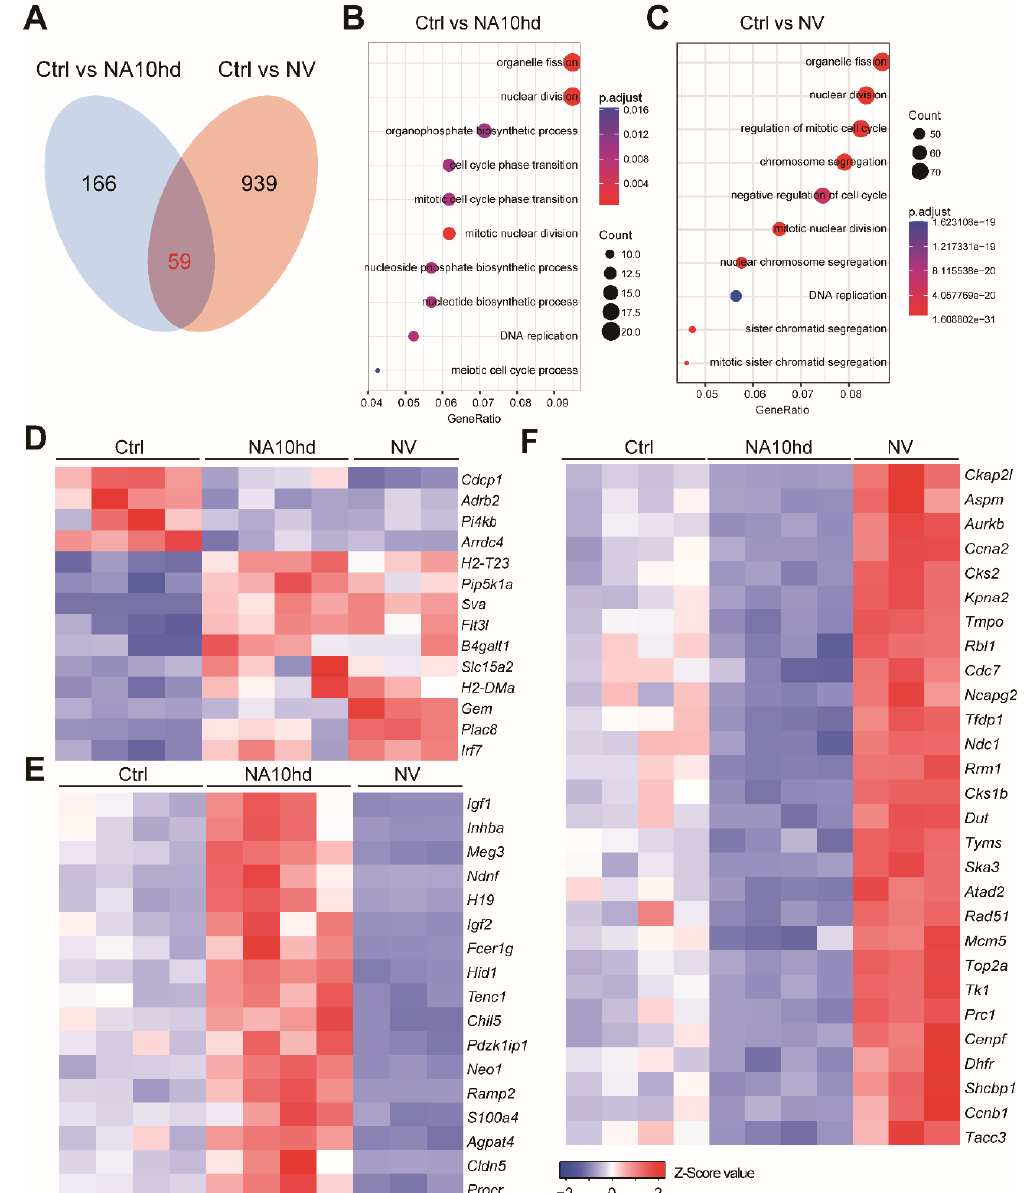
Figure 4. Gene expression pattern in HSC altered by NA10hd and NV expression. For each RNA-Seq sample, one thousand HSC (Lin − c-Kit + Sca1 + CD135 − CD150 + ) from NA10hd, NV, or littermate control mice were sorted as input cells. The raw reads (fastq files) were aligned to NCBIM37 mouse genome by hisat2 software. Gene expression value (raw counts) was extracted using featureCounts. DESeq2 was used to normalize the gene expression matrix and find out the differential expression genes (DEGs). ( A ) Overlap DEGs (p.adj < 0.05, fold change > 1.5) in NA10hd-HSC and NV-HSC compared with control (Ctrl) HSC. ( B ) GO enrichment (EGO) analysis of differential expression genes (DEGs) in NA10hd-HSC. The EGO analysis was performed by a clusterProfiler R package. ( C ) GO enrichment (EGO) analysis of DEGs in NV-HSC. ( D ) Heatmaps of overlapping DEGs with a similar expression alteration trend in NA10hd-HSC and NV-HSC. ( E ) Heatmaps of DEGs that were up-regulated in NA10hd but down-regulated in NV-HSC. ( F ) Heatmaps of DEGs that were down-regulated in NA10hd but up-regulated in NV-HSC. Heatmaps were plotted by gplots (heatmap.2). Columns represent the indicated biological replicates of each population ( D – F